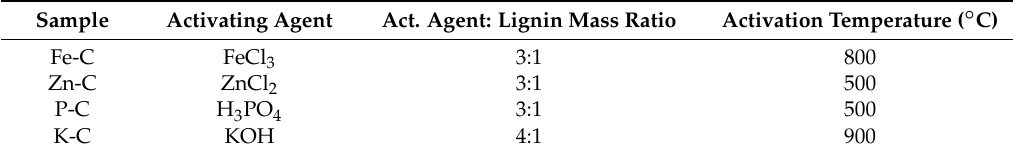
Table 1. Activation conditions of the different